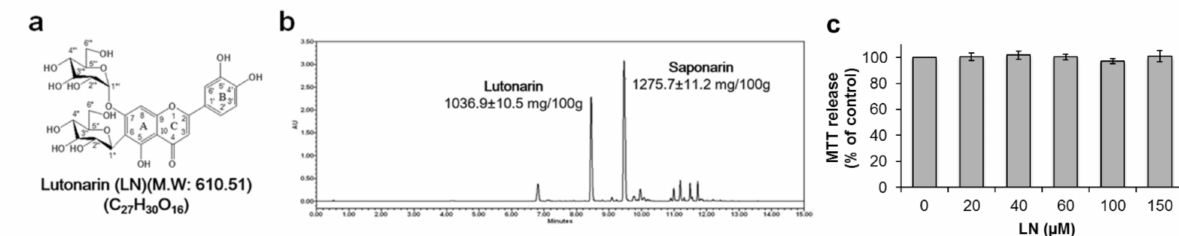
Figure 1. Identification of lutonarin (LN) in methanol extract of barley seedlings. ( a ) Chemical structure of LN; ( b ) Repre- sentative ultra-performance liquid chromatography and photodiode array (UPLC-PDA) chromatogram of barley sprout extract showing that saponarin and LN are the major constituents; ( c ) RAW 264.7 macrophages were pretreated with the indicated LN concentrations for 4 h, and then cultivated for 24 h with or without 1 µ g/mL lipopolysaccharide (LPS). MTT assay of viable cell number after LN treatment. Values are presented as the mean ± SEM of three independent replicates. Lutonarin did not reduce viable cell number within the tested concentration